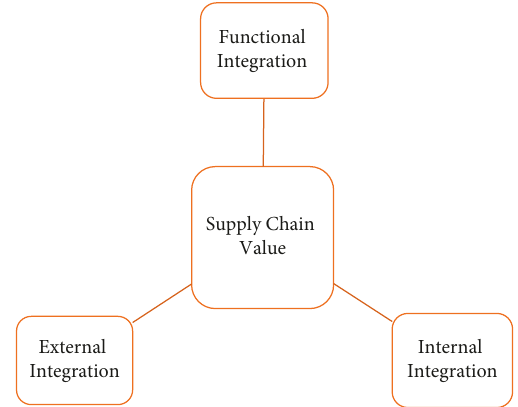
Figure 1: A three-dimensional approach to supply chain value